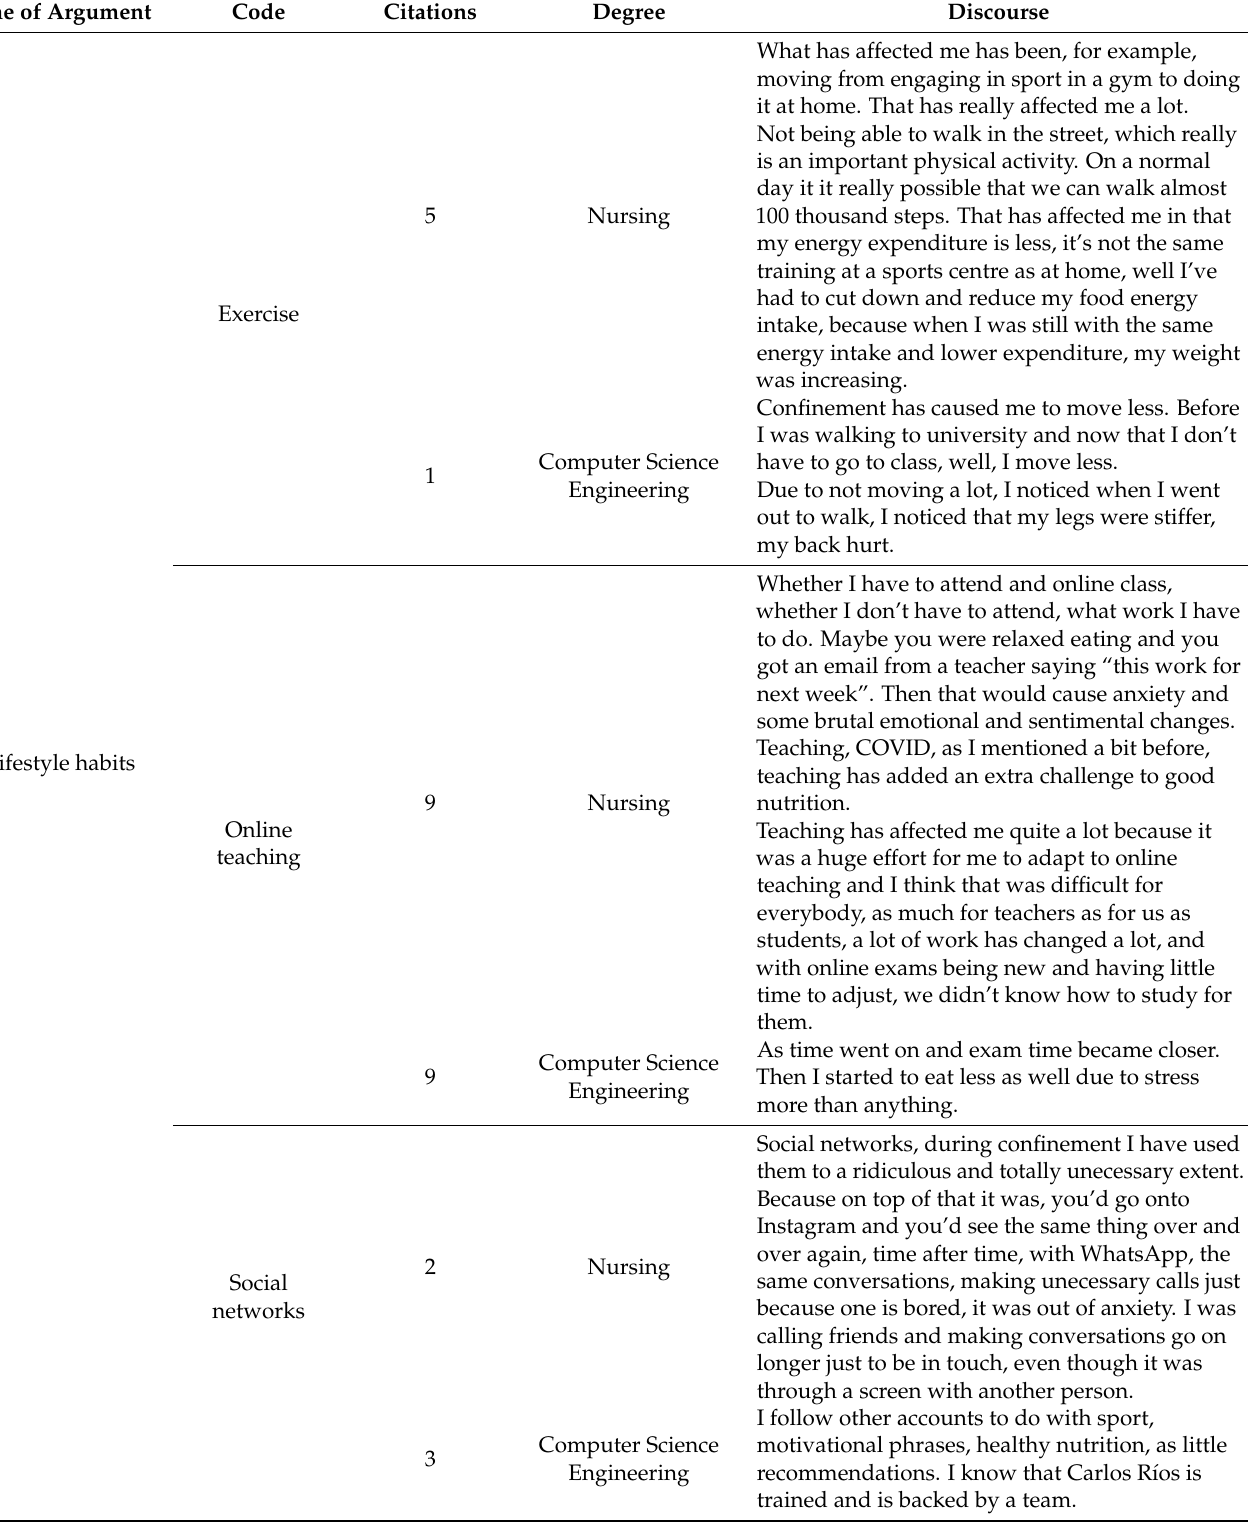
Table 4. Codes and nursing and engineering student discourse on lifestyle habits, with regards to physical exercise, online teaching, and social